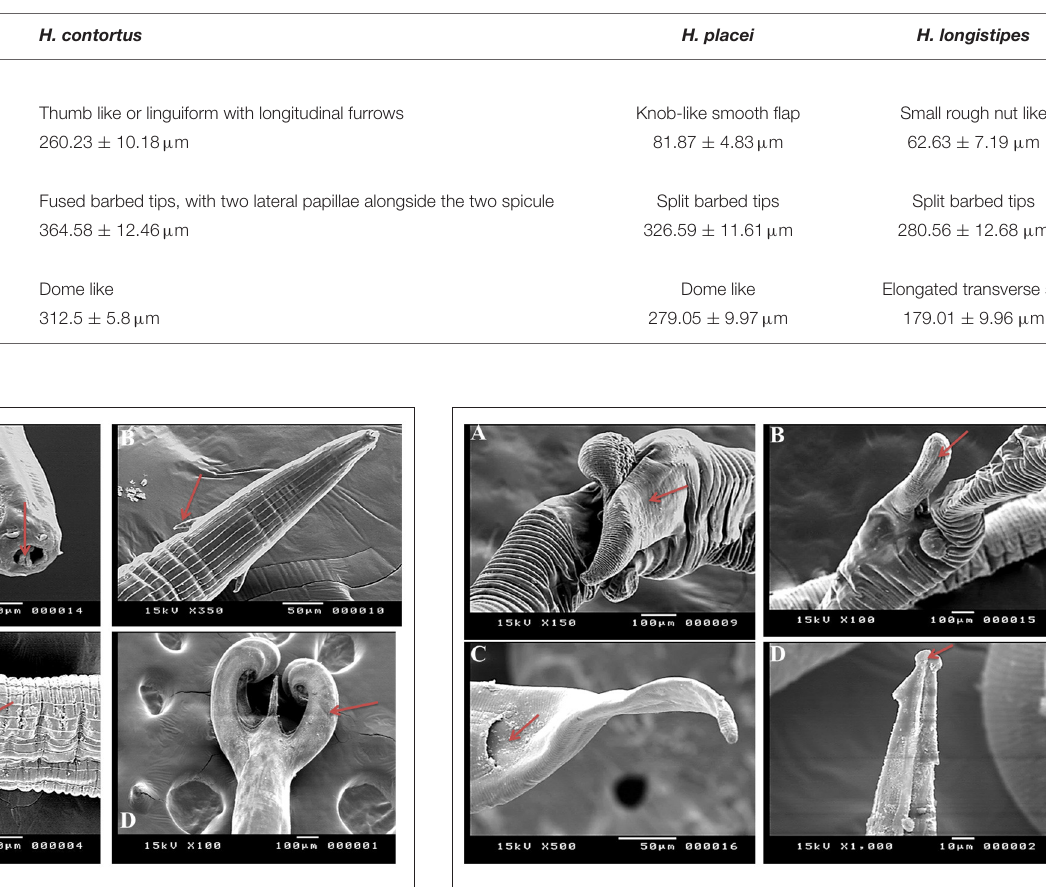
FIGURE 6 | Morphometric appearance of Haemonchus contortus isolated from the abomasum of goats using scanning electron microscopy. (A,B) The vulvar region of female H. contortus showing a polymorphism vulvar flap (arrow). (C) The tail region of female H. contortus showing an anal pore (arrow). (D) The spicules of male H. contortus showing fused barbed tips